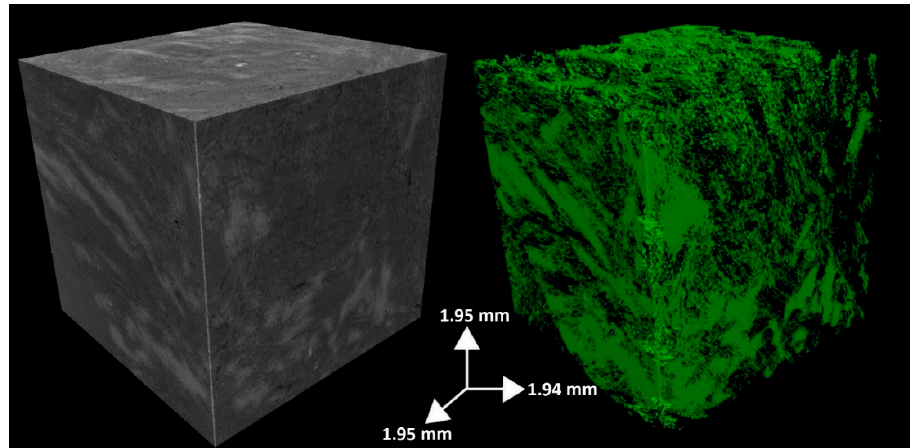
Figure 7. 3D rendering of a selected part of one specimen analyzed by means of synchrotron radiation X-ray micro-tomography: in the left picture, light colors correspond to high-density phases, while dark colors correspond to low-density phases; in the right picture, a green color is associated with the highest-density phase (i.e., tremolite). Note the 3D interlock between tremolite- and carbonate-rich portions.